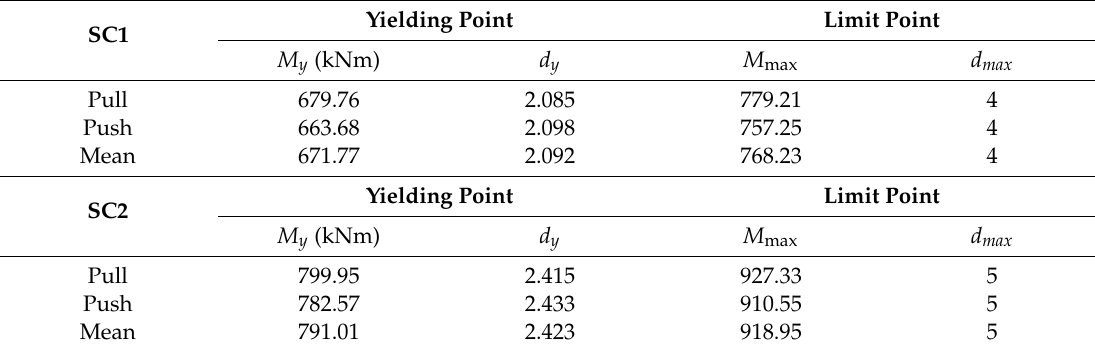
Table 6. Joint-bending moment and drift at different characteristic points.